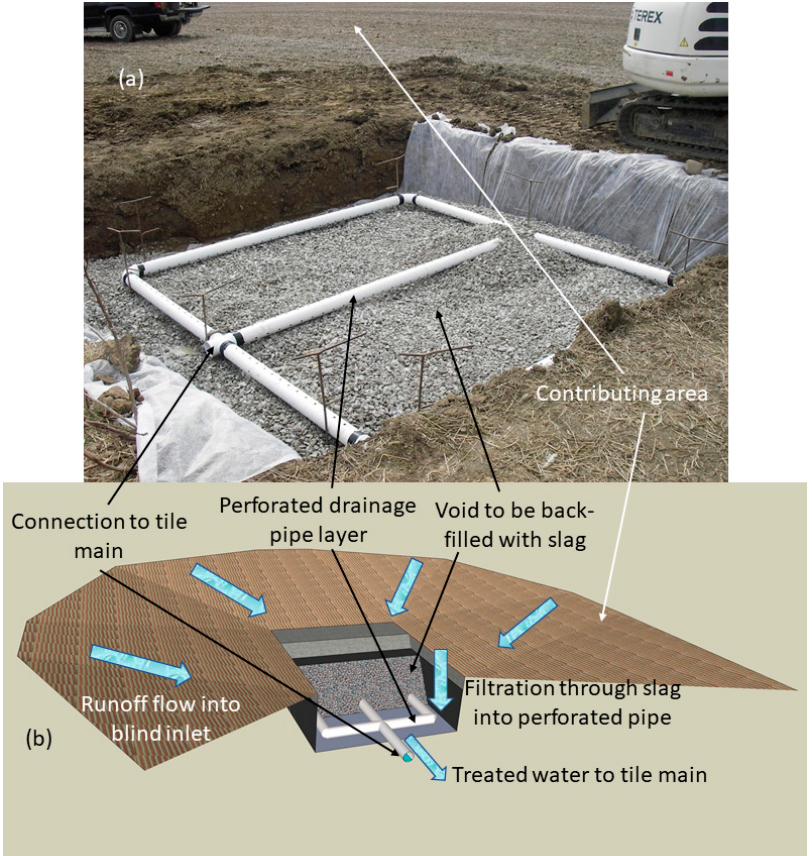
Figure 1. Photograph of the blind inlet during construction, specifically of the drainage pipe before being connected to the tile main and before final back-filling with steel slag ( a ), and diagram of the blind inlet constructed with steel slag for enhanced dissolved phosphorus (P) removal ( b ).